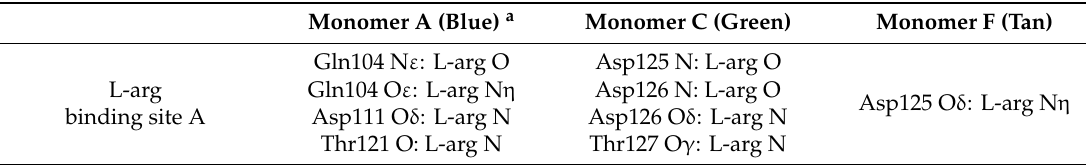
Figure 7. L-arginine binding-site interactions. The three subunits that form representative binding site A, shown, are colored according to Figure 3. Site A is defined as the binding site adjacent to helix α 5 of chain A (blue) and is formed by chains A and C (green) from one trimer and F (tan) from the other trimer. Residues whose sidechain functional groups are within hydrogen-bonding distance of the ligand are shown as sticks with atomic colors and black carbons. Residue numbers (one-letter code) are colored according to their subunit of origin. L-arg is shown in CPK spheres with atomic colors and cyan carbons. The position of the Gly107 alpha carbon is indicated by an orange sphere. Table 2. Interactions with L-arginine.